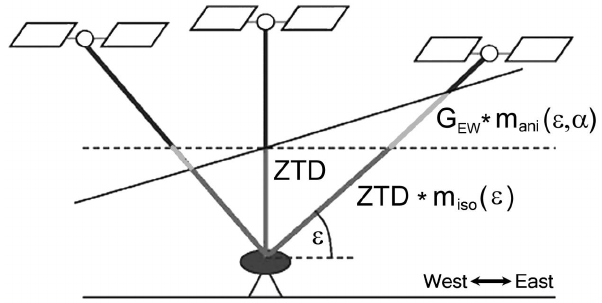
Fig. 2. Schematic representation of the GPS tropospheric observ- Figure 2: Schematic representation of the GPS tropospheric observables Zenith Total Delay (ZTD) and 2 ables Zenith Total Delay (ZTD) and horizontal gradients (EW and horizontal gradients (EW and NS components, here EW component G EW ). They are inferred from all 3 NS components, here EW component G EW ) . They are inferred simultaneously available GPS observations via elevation (  ) dependent isotropic mapping functions m iso (  ) 4 from all simultaneously available GPS observations via elevation and via azimuthal (  ) and elevation (  ) dependent anisotropic mapping functions m ani (  ). 5 ( ε) dependent isotropic mapping functions m iso (ε) and via az- imuthal ( α) and elevation ( ε) dependent anisotropic mapping func- tions m ani (ε,α)